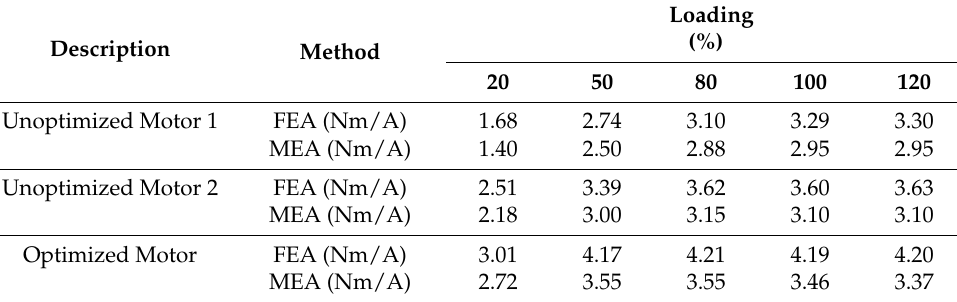
Table 9. Comparison of torque per ampere between the FEA and MEA results.